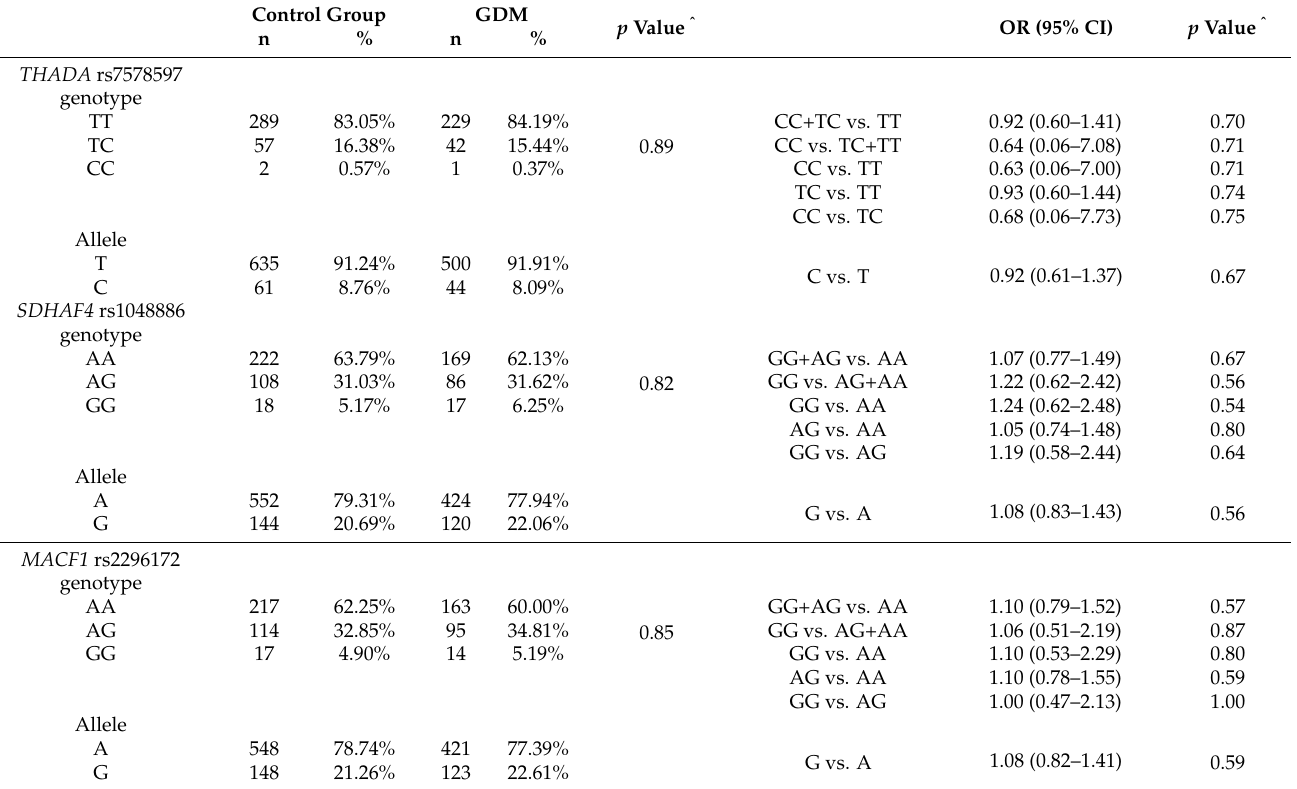
Table 1. Distribution of THADA , SDHAF4 , and MACF1 genotypes and alleles in women with GDM and the control group